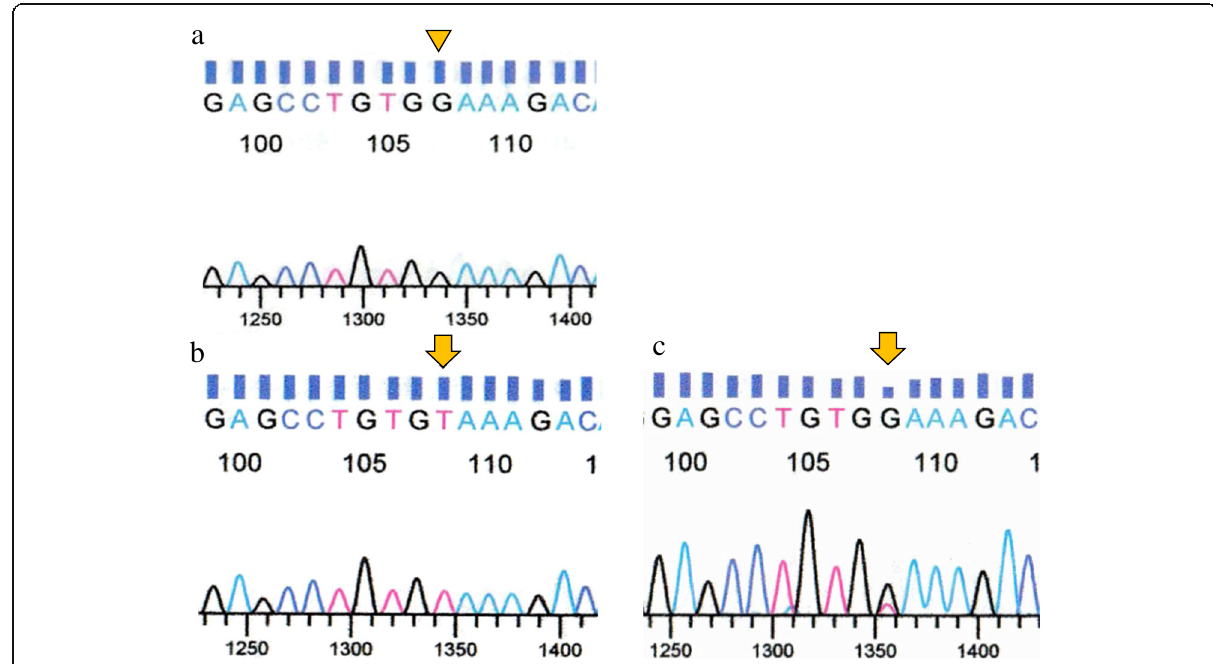
Fig. 3 Chromatograms of Sanger sequencing for RHOA G17V mutation in patients with AITL ( a , b ) and large cell PTCL-TFH ( c ). Arrow head indicates wild type ( a ), and arrows indicate 50G > T mutation ( b, c